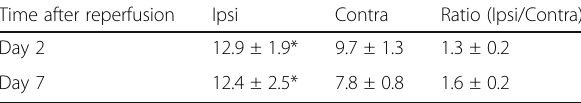
Table 3 V T values in the striatum after mild focal ischemia Time after reperfusion Ipsi Contra The data are expressed as mean±SD (day 2: n =5, day 7: n =4) of the V T values. Asterisks indicate significant differences compared with the contralateral side, * p <0.05. MCAO, middle cerebral artery occlusion; Contra, contralateral side; Ipsi, ipsilateral